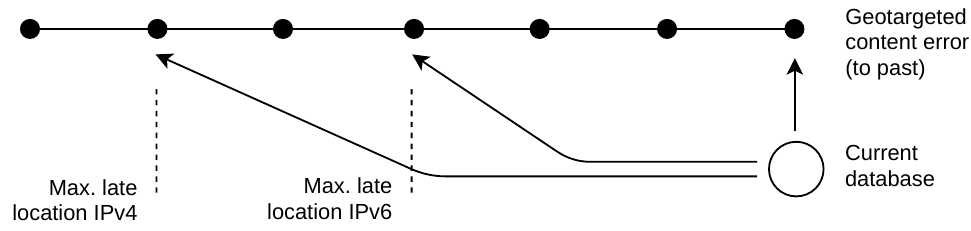
Figure 11. Geotargeted content use-case. Past viewers’ locations are used.